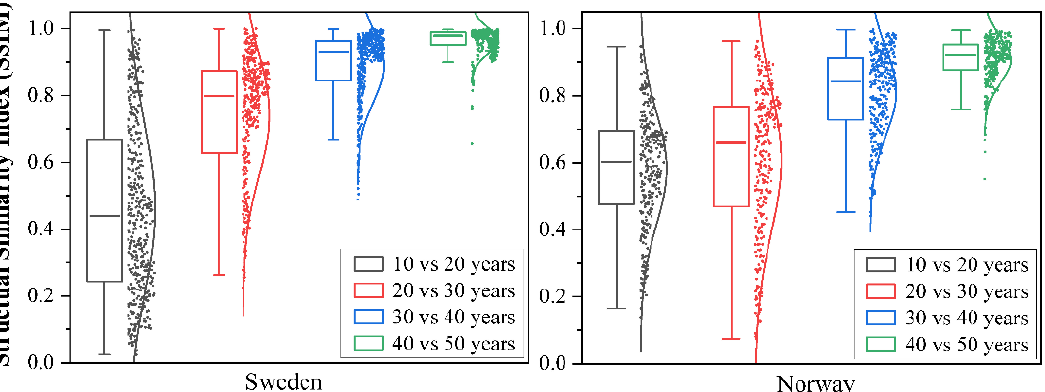
Figure 6. Modelled distribution of macrofungal species richness under different accumulated sam-